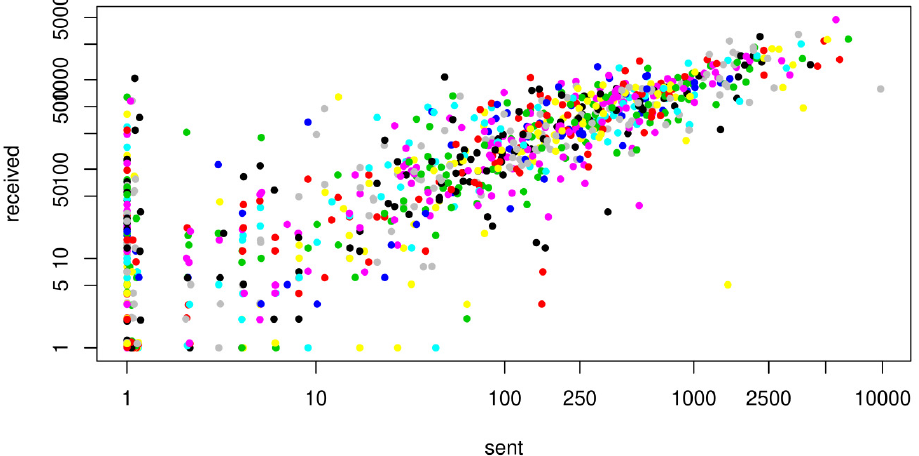
Figure 1. Number of emails sent and received by each individual; color represents the department the individual belong to (logarithmic scale).